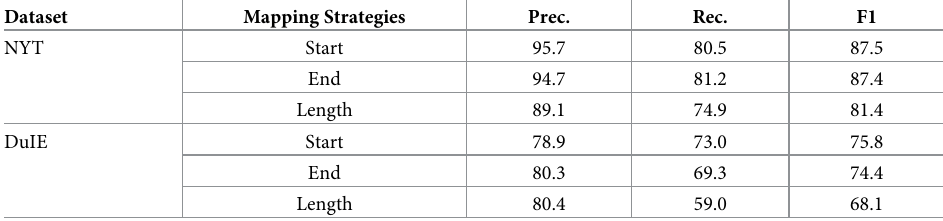
Table 4. Comparison experiment results of mapping